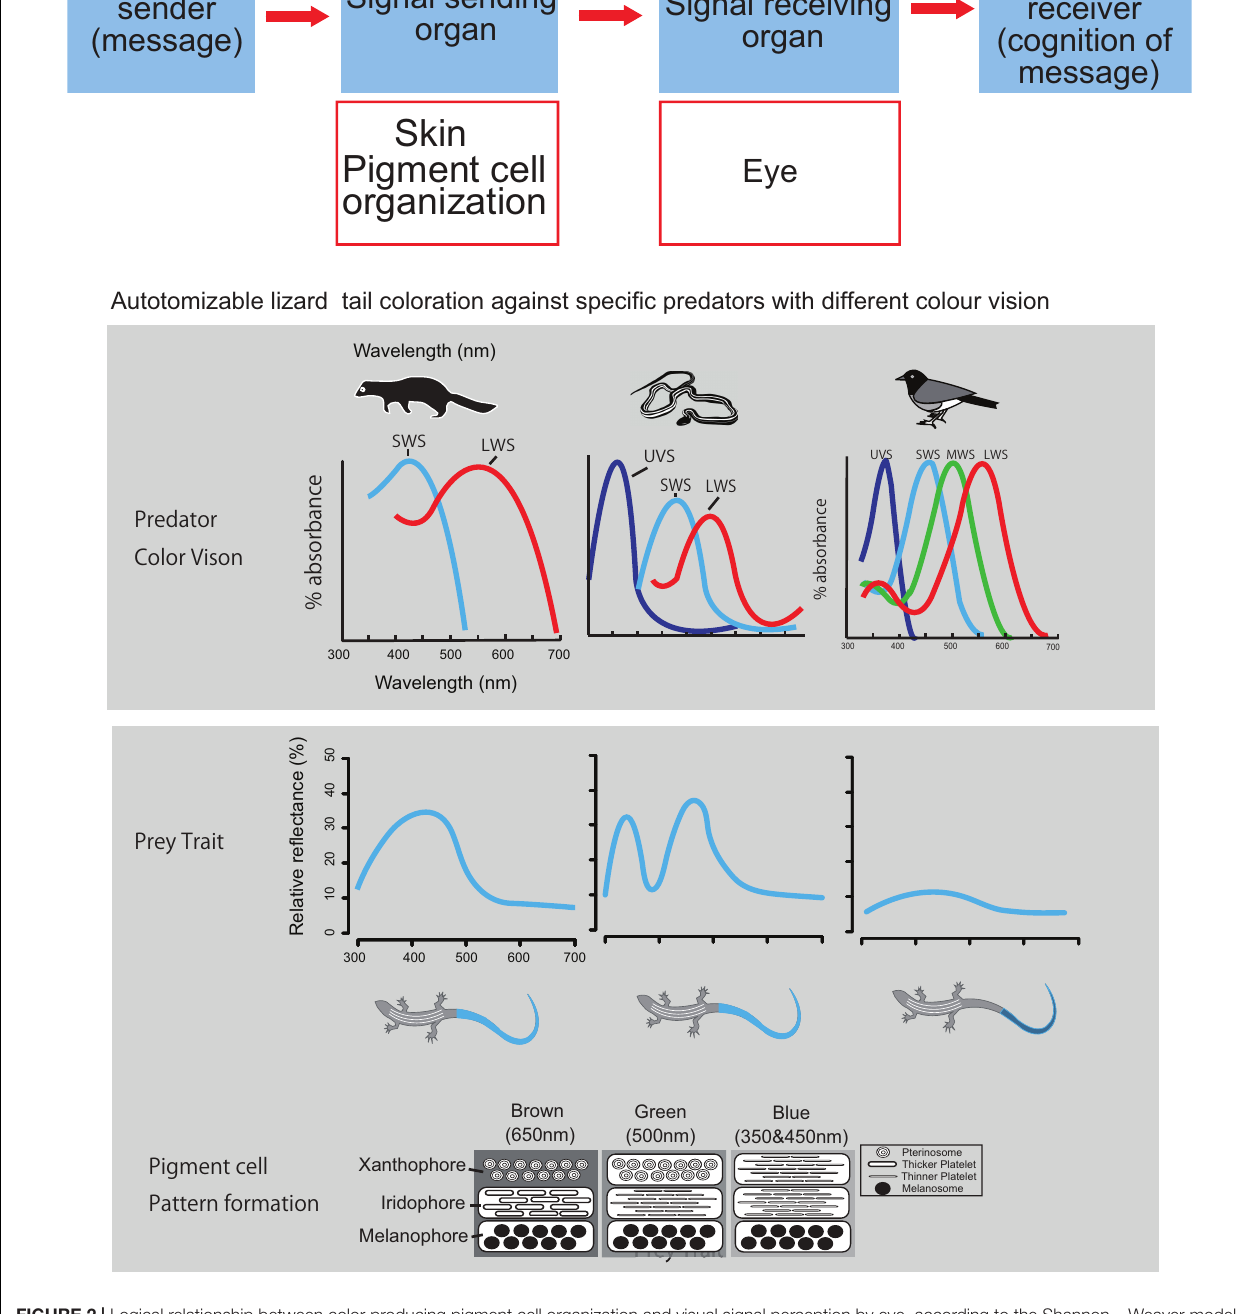
skin colors in reptiles (e.g., Kuriyama et al., 2013, 2017; Saenko et al., 2013; Murakami et al., 2016), tuatara (Alibardi, 2012), crocodiles (Alibardi, 2011), and chelonians (Alibardi,